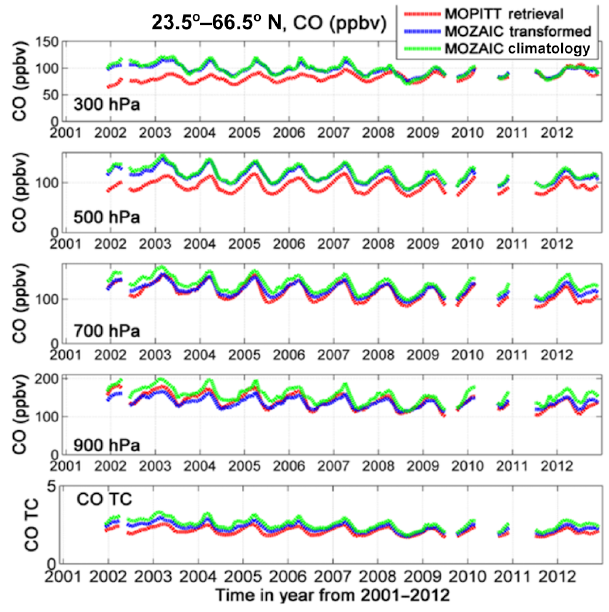
Figure 19. Zonally averaged time series of monthly mean CO VMR, at individual levels and total column, as retrieved by MO- PITT and from the trajectory-mapped MOZAIC-IAGOS CO clima- tology (untransformed, and transformed using MOPITT’s averaging kernels) for the latitude band 23.5–66.5 ◦